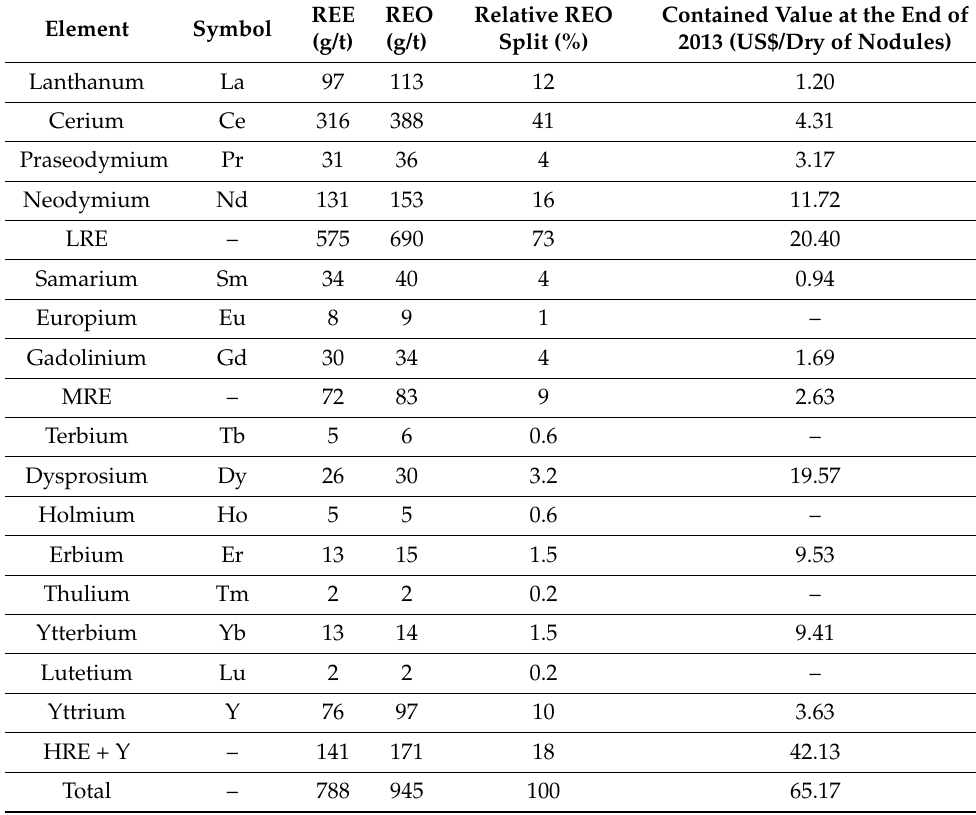
Table 3. Average rare earth content of manganese nodules from Tonga Offshore Mining Ltd., within the CCZ (a personal communication at the end of 2013; the ratio of the REE content in g/t to the REO in g/t was relatively constant between 0.83 and 0.87) [12]. Element Symbol